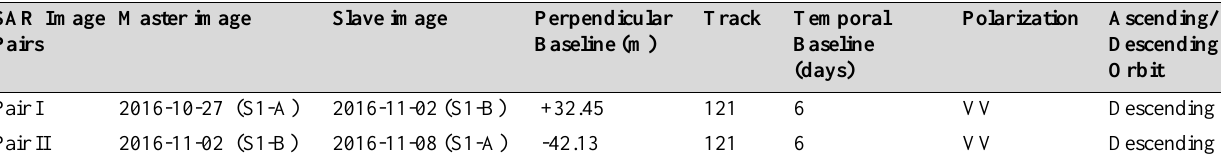
Table 1. List of S1 SAR image pairs used for InSAR of the Ngozumpa glacier relative. The phase difference at the reference point—rocks